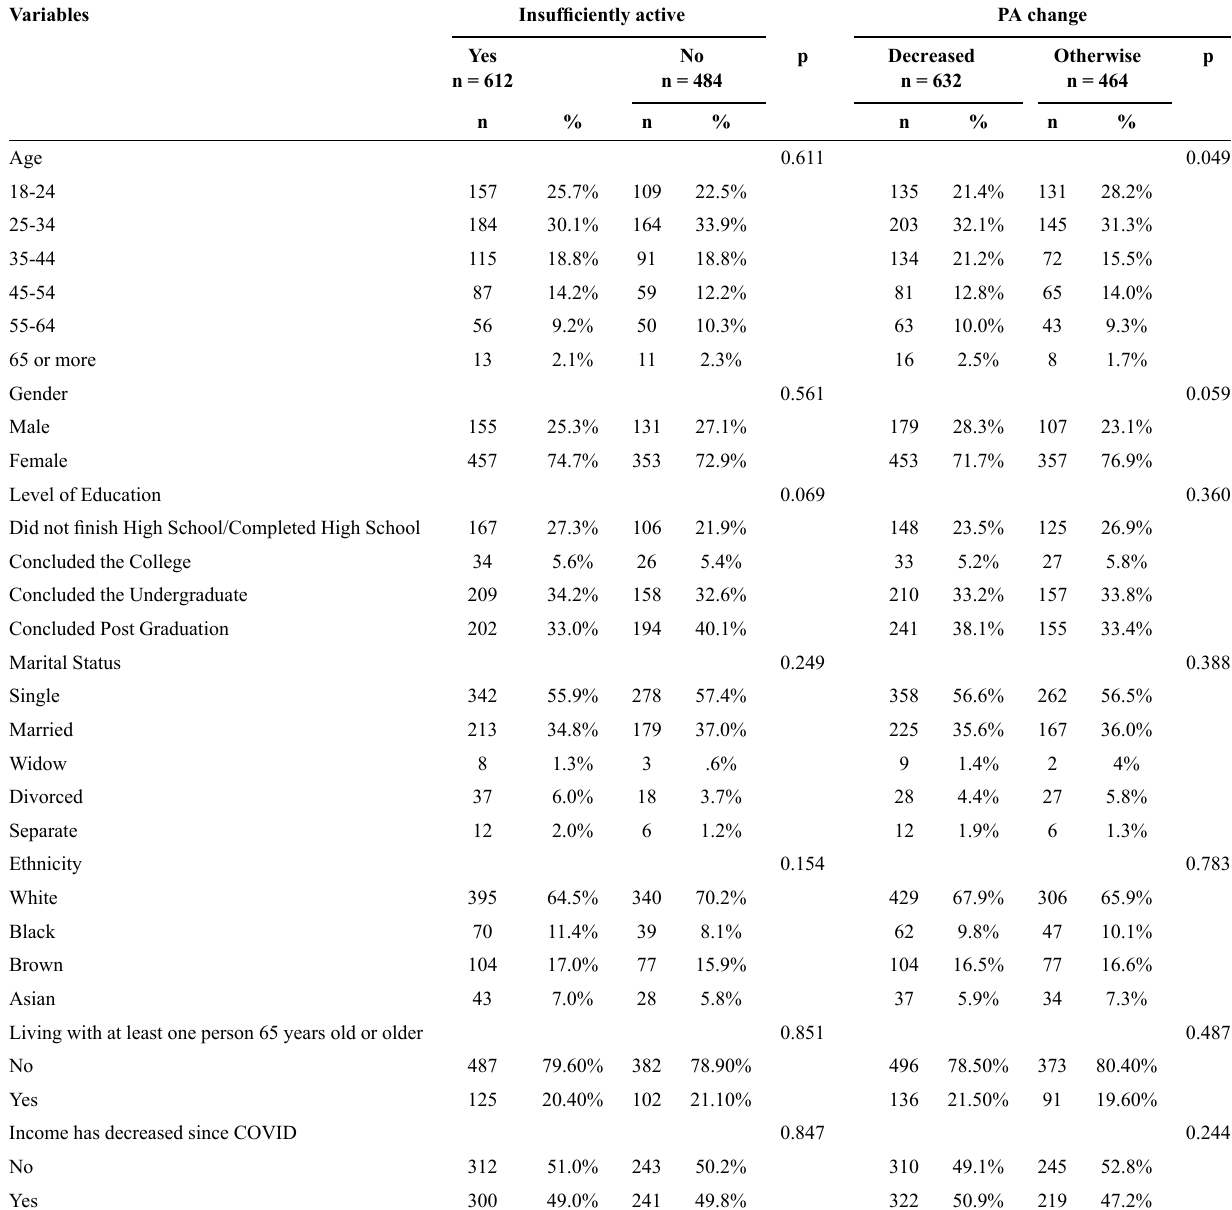
Table 1 - Sociodemographic profile of individuals, according to the variables Insufficiently active and PA change.